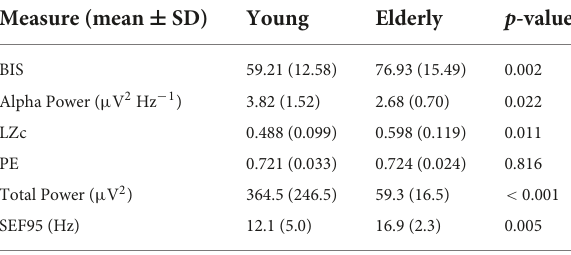
TABLE 3 Hypnotic measures at loss of consciousness